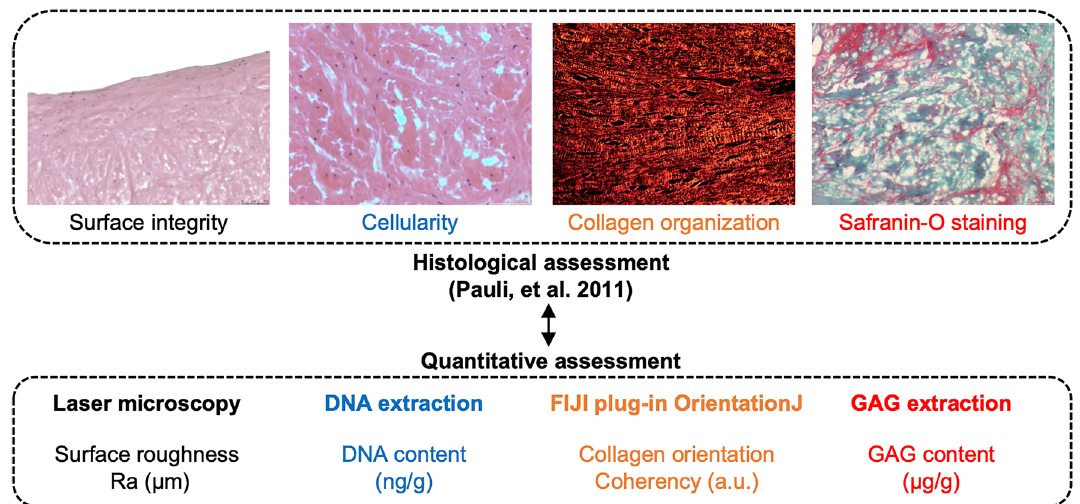
Figure 1. Comparison of Pauli’s histological grading system with surface roughness, DNA content, collagen orientation, and GAG content. Criteria used in Pauli’s histological grading system and the corresponding quantitative assessment. In quantitative assessment, the measurement methods, parameters, and units are described. Ra; arithmetical mean roughness.